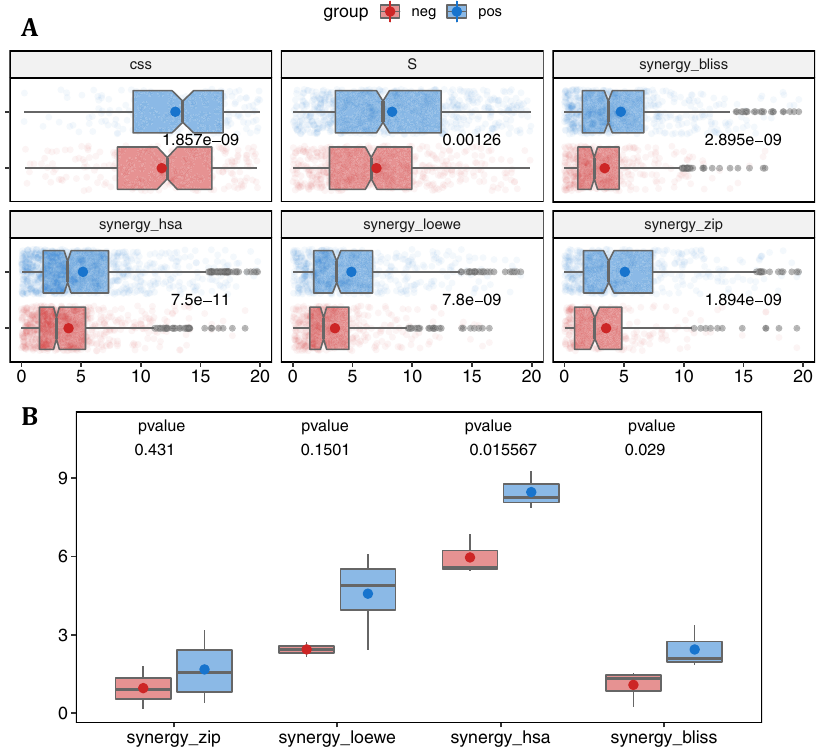
Fig. 8 Synergy of drug combinations. A The combinational sensitivity (CSS) and synergy scores (S, synergy_bliss, synergy_hsa, synergy_loewe, and synergy_zip) of drug combinations in the ALMANAC dataset. The top fi ve drugs of cluster 1 (Cabazitaxel, 5-FU, Cytarabine hydrochloride, Methotrexate, Bleomycin) and cluster 2 (CHEMBL17639, Ge fi tinib, Ixabepilone, Dexrazoxane, Eloxatin) for inter-cluster and intra-cluster combinations are shown in blue and red as the positive and negative groups, respectively. Each plot contains a scatter plot, a notch box plot, and mean values for each group ( n = 1300). The coloured dots and lines in the centre of the notched boxplots represent the mean and median, respectively, and the notches on the sides of the box plots can be interpreted as a comparison interval around the median values. The left and right hinges denote the 25th and 75th percentiles, respectively, while the left and right whiskers show values that are less than 1.5 times the interquartile range (IQR). Outlier predictions are shown by the points outside the whiskers, while the colourful spots in the dim background show how the original data was distributed. The p-value represents the one-sided Student ’ s t-test signi fi cance for each score separately. B The measured synergy of drug combination scores in the experimental validation of selected drugs based on network modelling of the Beat AML data in three AML cell lines. Four measures of synergy, that is, ZIP, HSA, Bliss, and Loewe, are seen as box plots for the experimental con fi rmation of the chosen predictions ( n = 14). Inter-cluster drug combinations are shown in blue as the positive group, and the intra-cluster combinations are shown in red as the negative group. The mean and median are shown by coloured dots and lines in the centre of the boxplots, respectively. The 25th and 75th percentiles are represented by the left and right hinges, respectively, while the left and right whiskers re fl ect values smaller than 1.5 times the interquartile range (IQR). The p-value represents the two-sided Student ’ s t-test signi fi cance for each score separately. All source data are provided as a Source Data fi